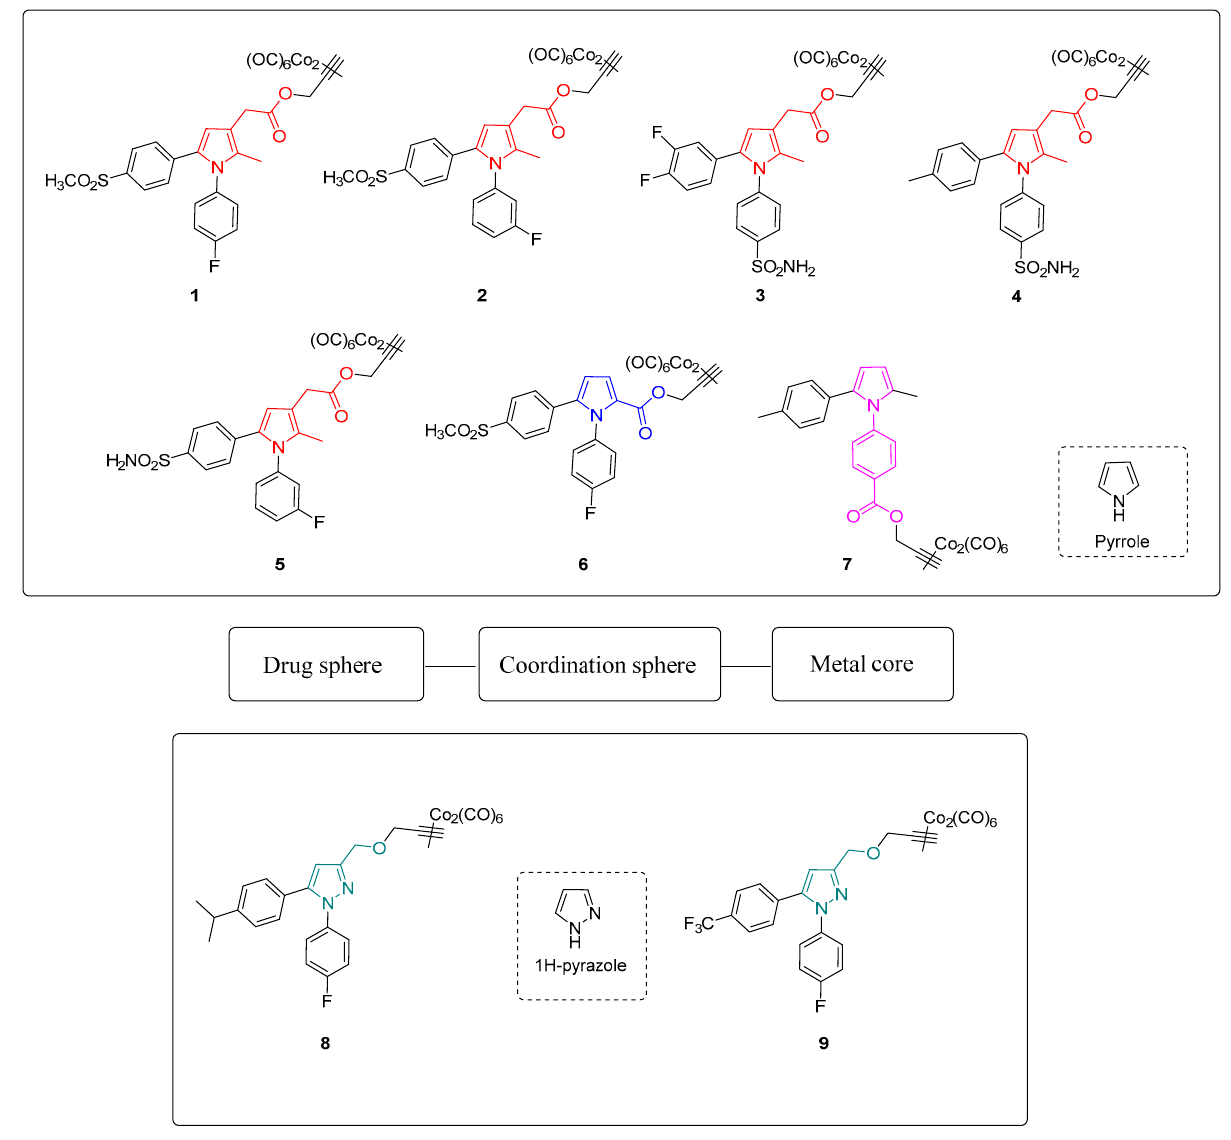
Figure 1. Chemical structures and conceptual model of compounds 1 - 9 .